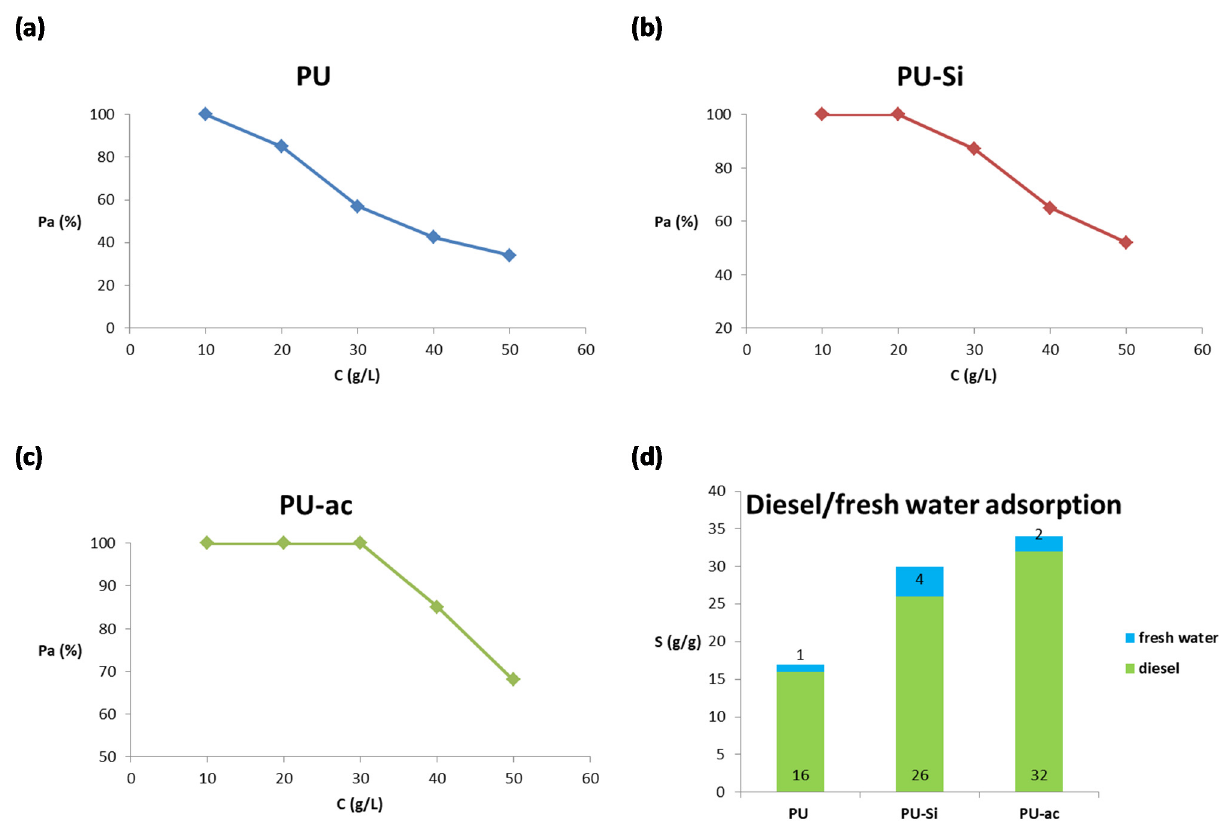
Figure 7. ( a ) Percentage of adsorption for PU 1 at different starting concentrations; ( b ) percentage of adsorption for PU-Si 2 at different starting concentrations; ( c ) percentage of adsorption for PU-ac 3 at different starting concentrations; ( d ) total adsorption capacity for the three types of materials, 1–3, tested with respect to diesel and fresh water.